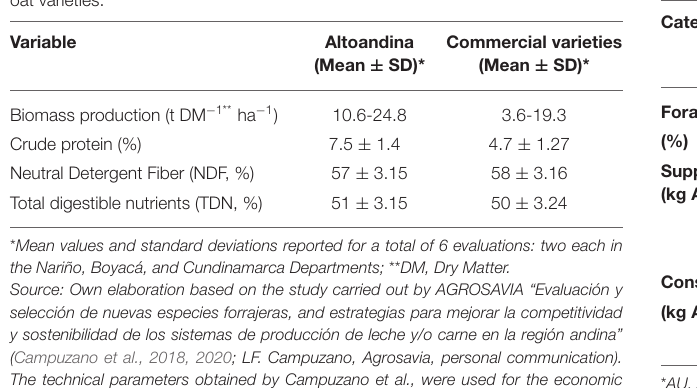
TABLE 2 | Composition of the evaluated